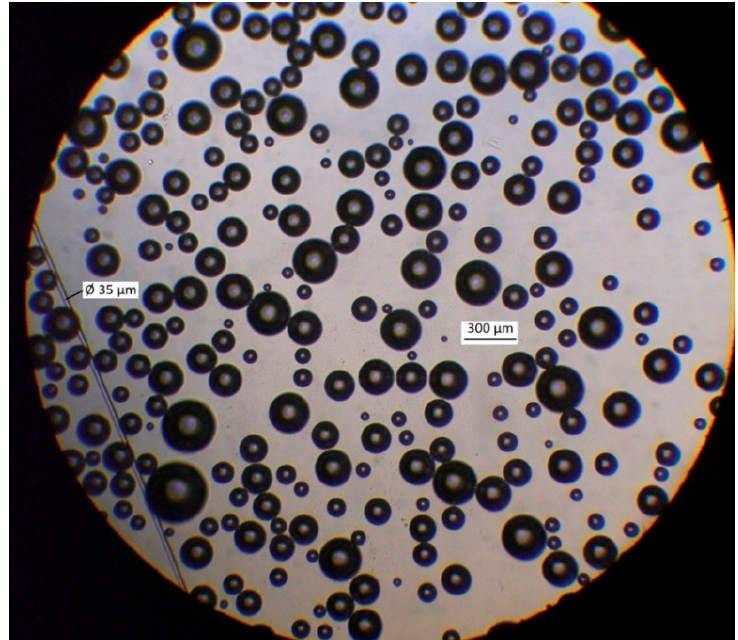
Figure 4. Micrograph of microbubbles produced by MBGen-0.012 air-in-water microdispersion generator in Lilaflot 821M solution of 0.5 g/L.